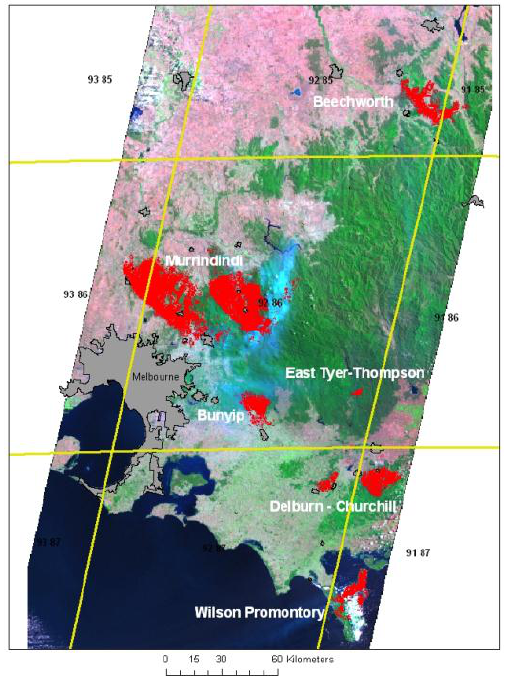
Figure 1. Overview of 2009 mapped fires (bright red) and their proximity to the Melbourne urban area and Landsat path 92 and rows 85-87 (yellow line grid).